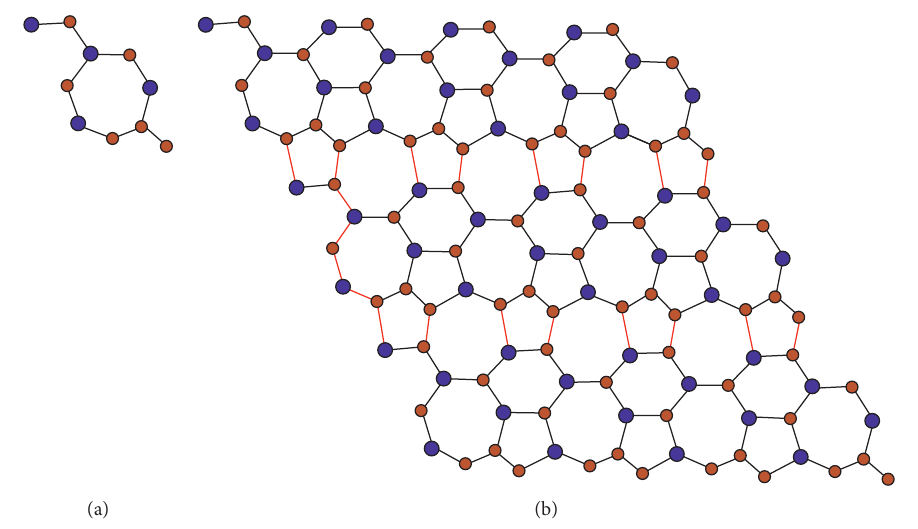
Figure 1: The unit cell and Si